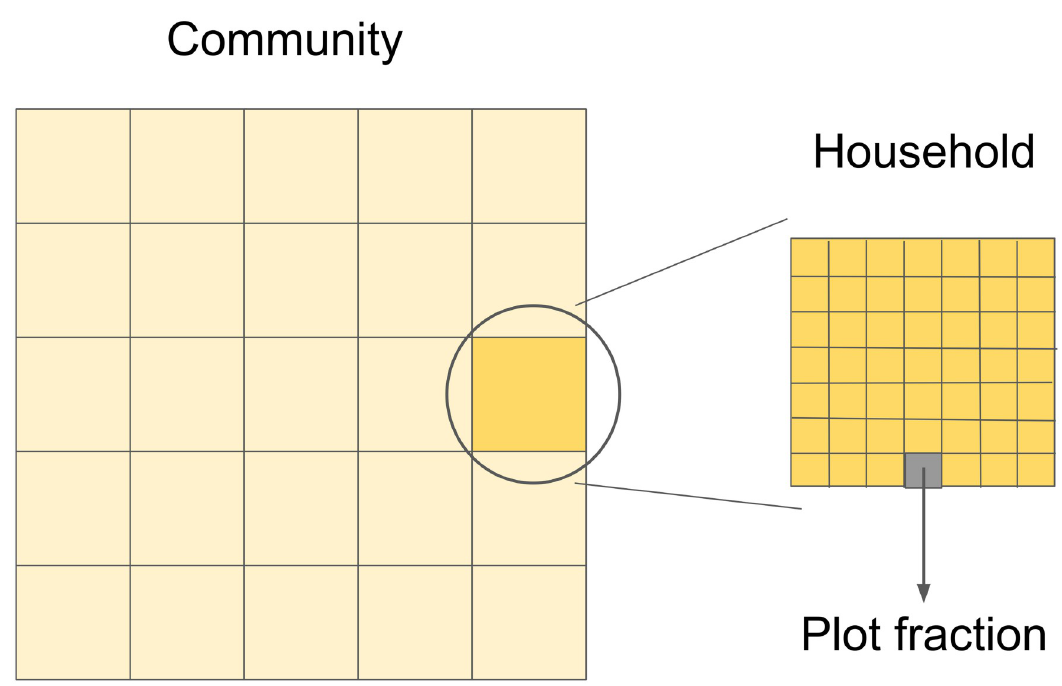
Fig 1. Diagram with the three model levels: Community, household, and plot fraction.